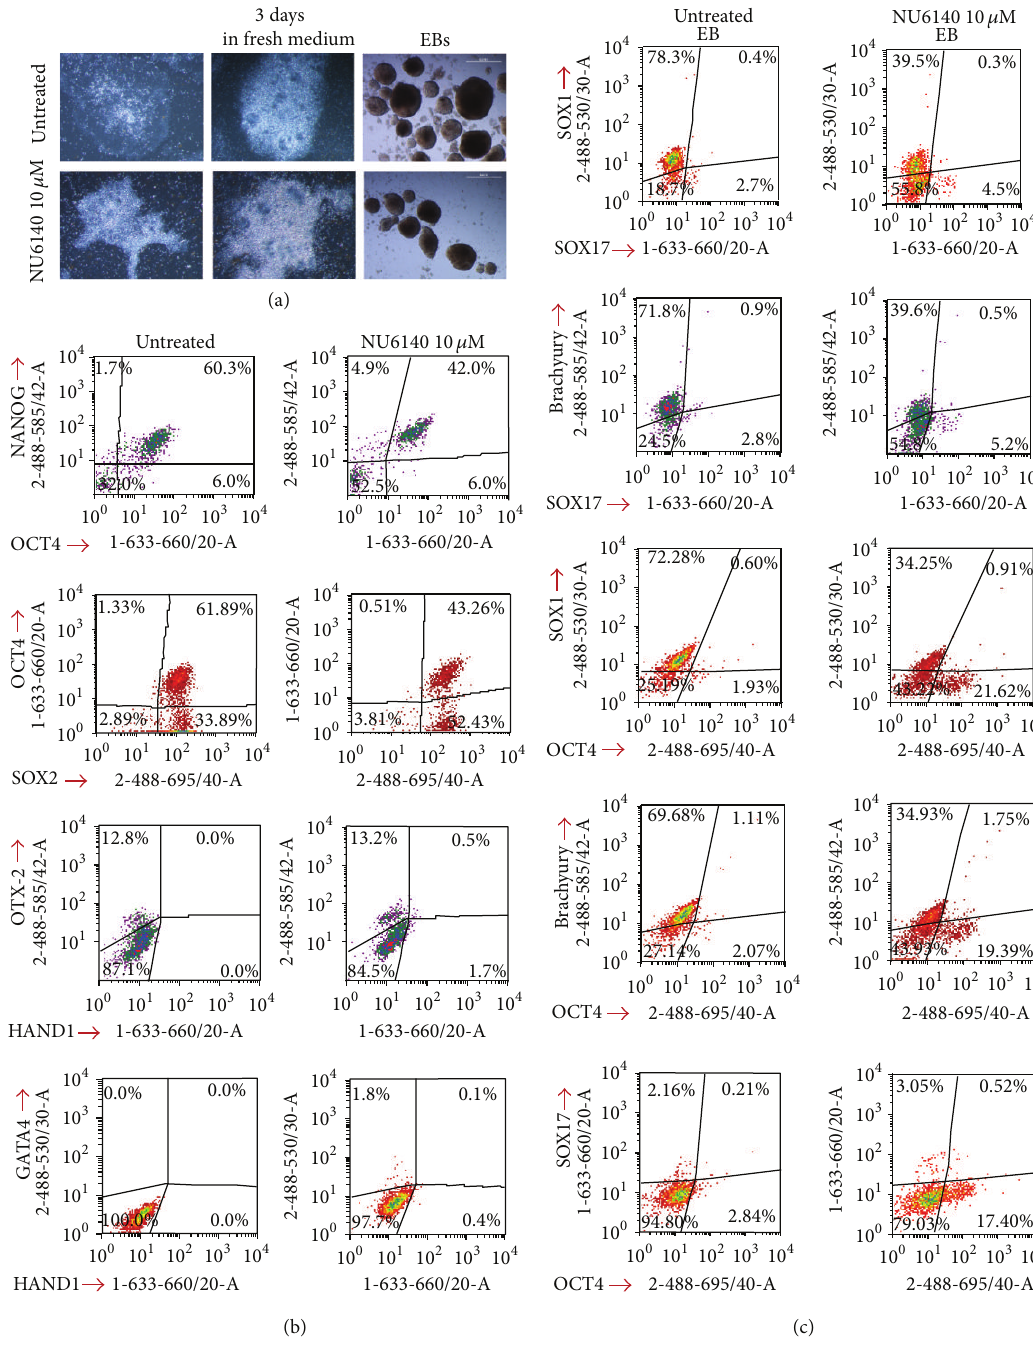
Figure 6: NU6140 treatment causes changes in the colony structure and differentiation potential of hES cells. hES cells were treated with NU6140 (10 𝜇 M) for 24 h and then cultured in fresh mTeSR1 maintenance medium for a further 3 days with the medium changed daily. Embryoid bodies were formed from hES cells treated with NU6140 or from untreated hES cells. (a) Morphological changes in colony structure after NU6140 treatment and formation of EBs. (b) Fixed and permeabilised hES cells were stained with anti-OCT4 (Alexa Fluor 647 conjugate), anti-NANOG (PE), and anti-SOX2 (PerCp-Cy5.5) antibodies and with DAPI. Other hES cells were stained with anti-GATA4 (NorthernLights, NL-493 conjugate), anti-OTX-2 (NL-557), anti-HAND1 (NL-637) antibodies and with DAPI. (c) Differentiation into three germ cell layers as detected by flow cytometric assay. Fixed (1.6% PFA) and permeabilised cells from dissociated embryoid bodies (EBs) were stained with anti-SOX1 (NL-493), anti-Brachyury (NL-557), anti-SOX17 (NL-637), and anti-OCT4 (PerCp-Cy5.5) antibodies and with